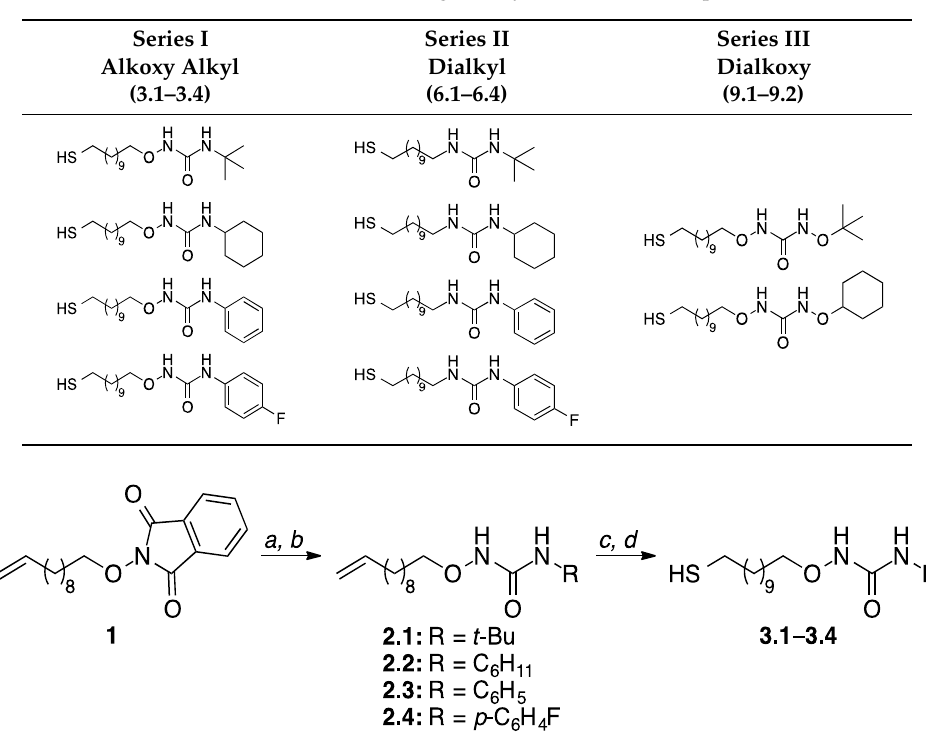
Table 1. Panel of thiol-urea ligands synthesized for comparison.